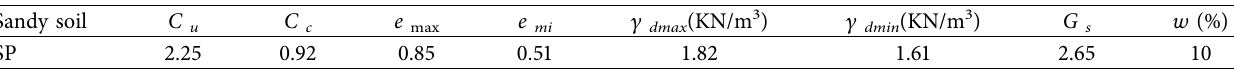
Table 2: Physical indexes of sandy soil.